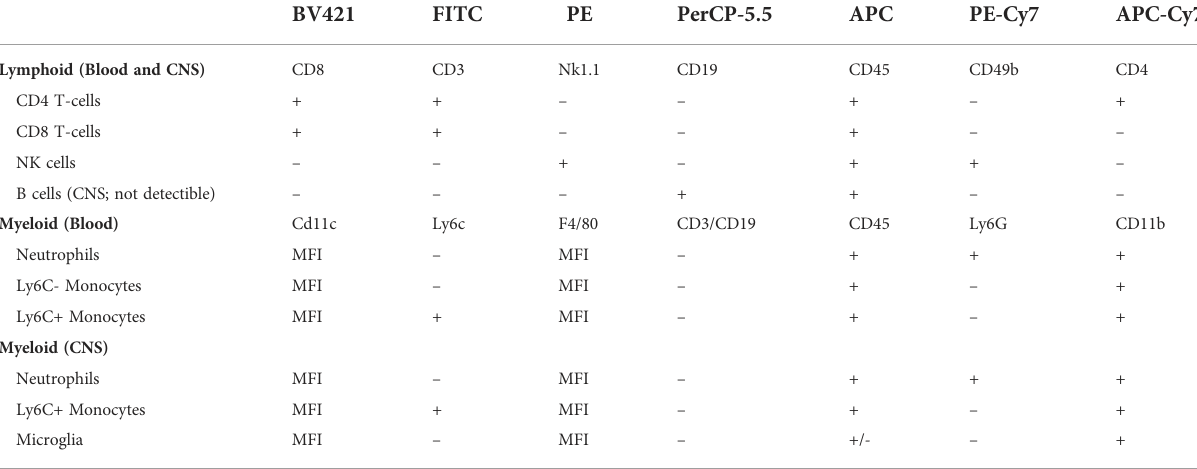
TABLE 1 Flow cytometry antibodies for blood and CNS immune cell